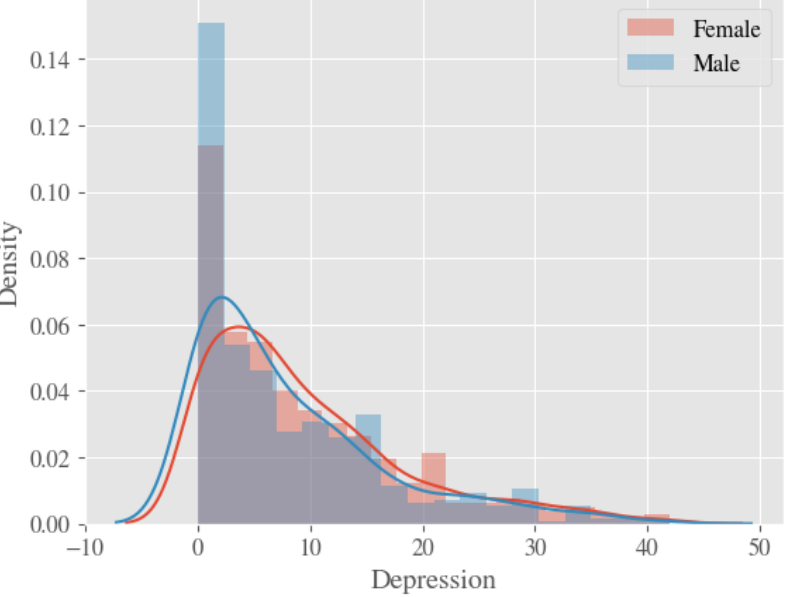
Figure 1. The Distribution of Levels of Stress in Men and Women.